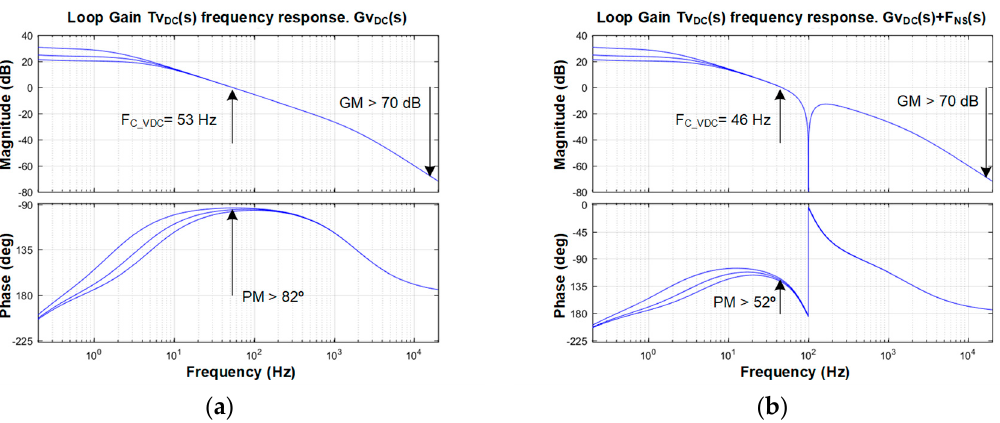
Figure 4. Loop gain frequency response of T vDC (s) @ I DC = [0.2, 0.4, 0.6] A. C DC = 50 µF: ( a ) without notch SOGI filter, ( b ) with notch SOGI filter.